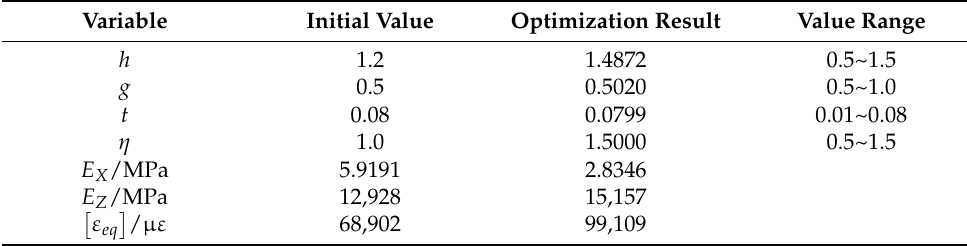
Table 10. Optimization results of honeycomb structure parameters.